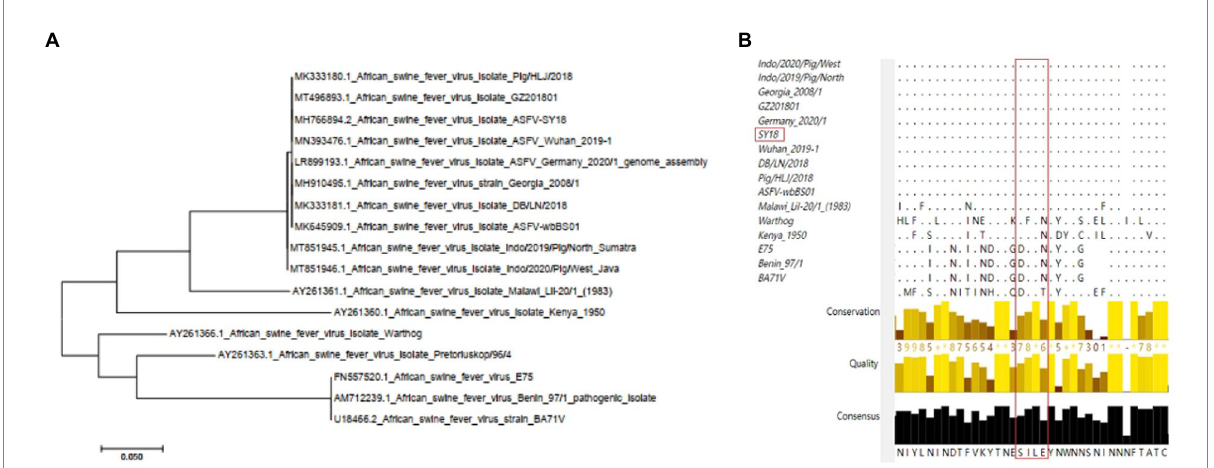
FIGURE 5 Conservation analysis of CD2v extracellular domains and epitopes in different representative ASFV strains. (A) Phylogenetic trees were established for the phylogenetic analysis of 17 representative ASFV strains. The NJ tree was established by MEGA7.0. (B) Analysis of the conservation of epitopes in 17 representative strains by